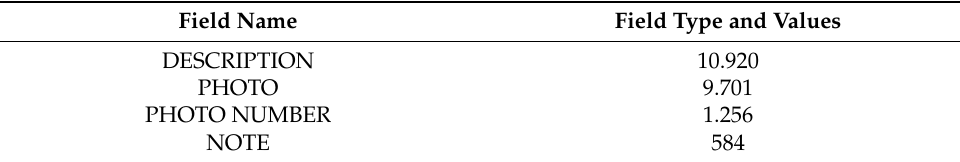
Table 1. Types and names of fields of the insert